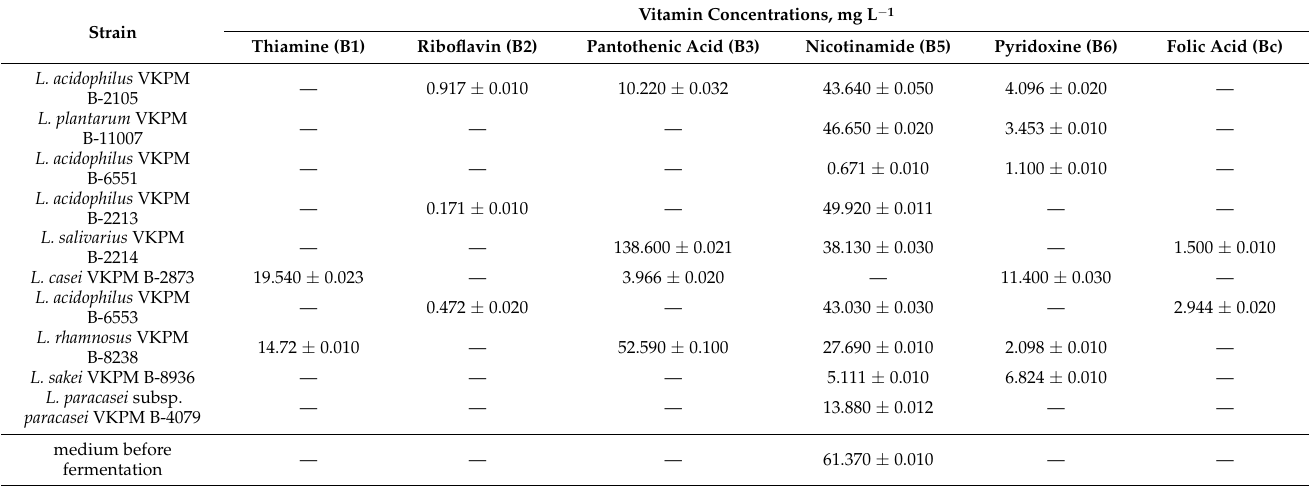
Values are the mean ± SD of three determinations of three replicates. The concentrations of each B vitamin differed significantly between the strains ( p < 0.05). Table 13. Concentration of B vitamins in lactic acid bacteria fermentation